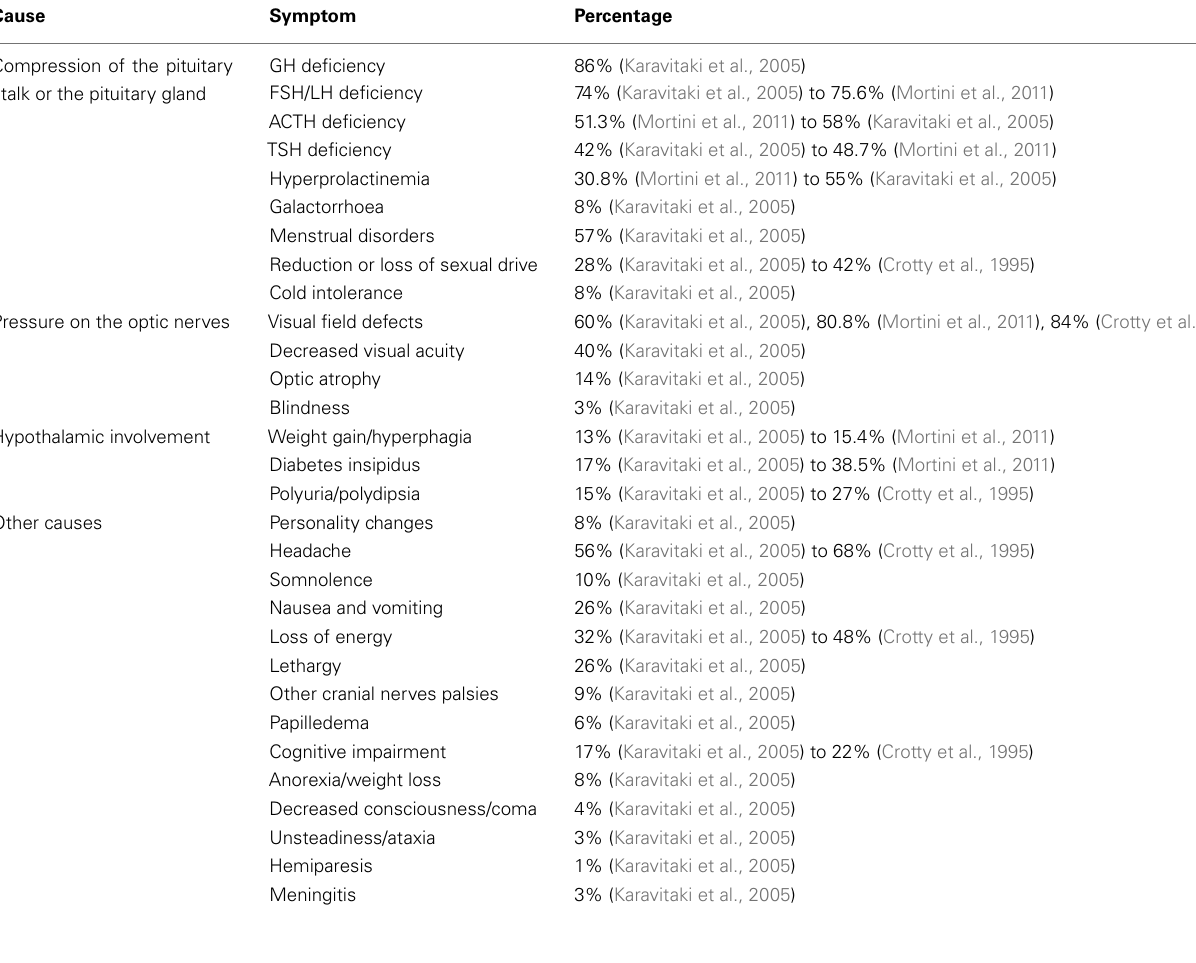
Table 1 | Presenting symptoms and clinical manifestations of adults with